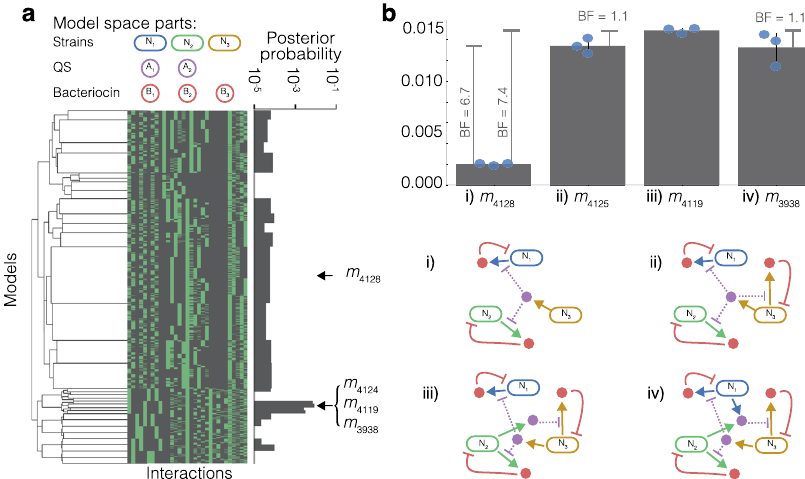
Fig. 4 Output of AutoCD for three-strain stable steady state objective. a Dendrogram is generated by hierarchical clustering of the adjacency matrices for each model in the three-strain model space. We set the limit of number of levels to 5, in order to show high level groups. Each column of the heatmap represents a possible interaction between state variables, where green indicates the interaction exists for the model and black indicates absence of the interaction. The posterior probability plot shows the average posterior probability within each group of models. b Shows the models with highest posterior probability when subsetted for number of parts expressed, in order of increasing complexity (3, 4, 5 and 6 expressed parts). The bar chart shows the mean model posterior probability across three experiments, represented by the scatter points, the error bars indicate the standard deviation. n = 3, where each replicate consists of 825,000 accepted particles. Bayes factors (BF) are shown for pairwise comparison of the three models and error bars show the standard deviation between three repeat experiments. Model schematics show the interactions between strains (blue, green and red), bacteriocin (red) and QS molecules (purple). Models with two parts showed posterior probability 0.0 and are not